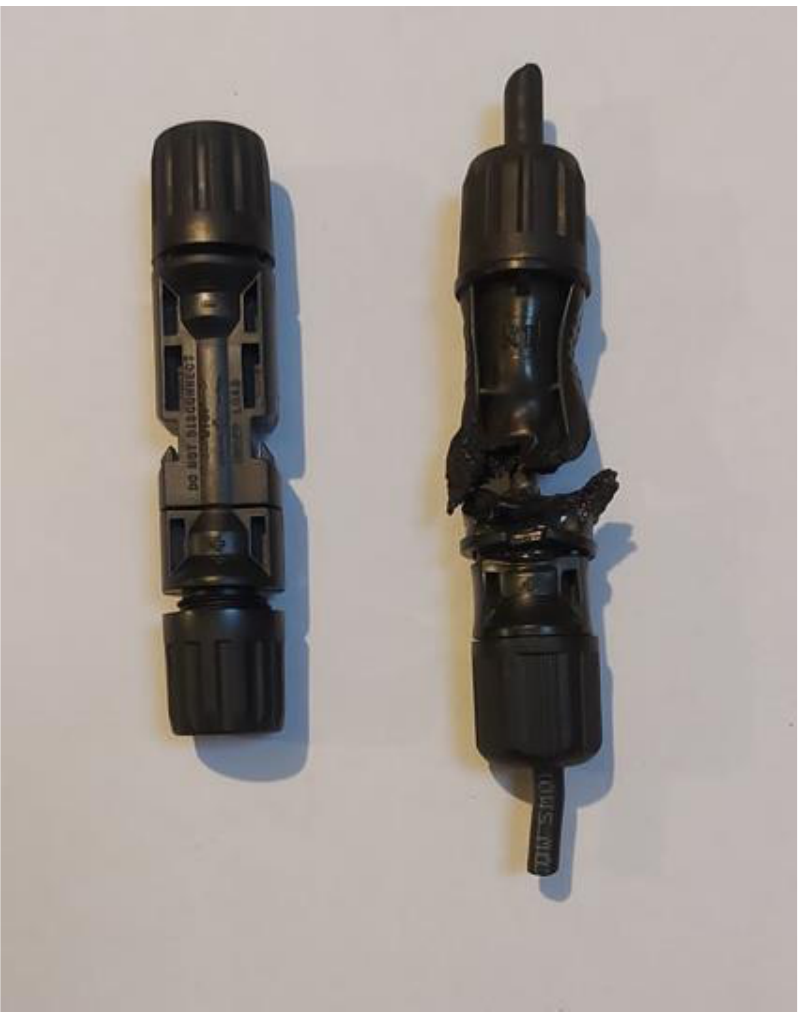
Figure 13. Comparison of the shape of MC4 connectors — the connector on the left is fully functional and the connector on the right is damaged due to overheating.